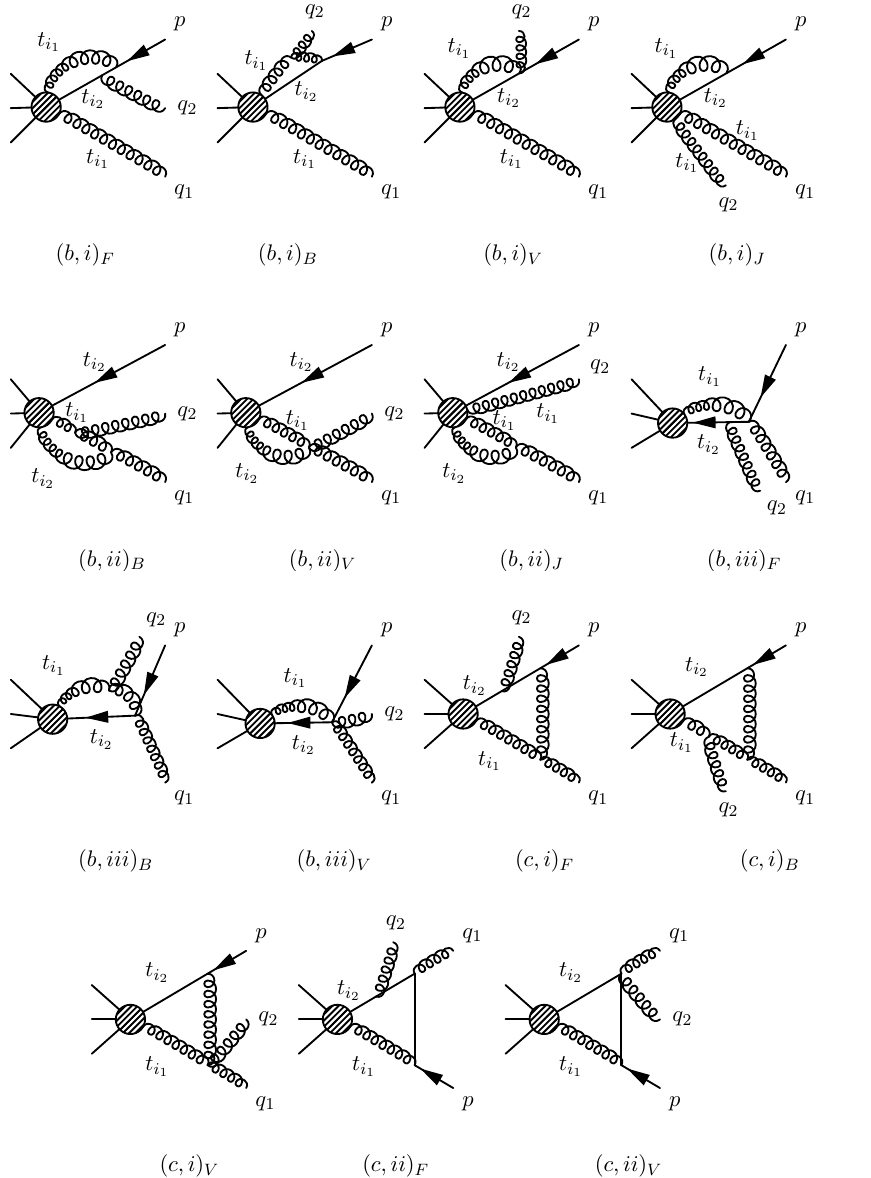
Figure 11 . 1PI diagrams contributing to the mixing J B 2 in the collinear sector with fermion number F i =